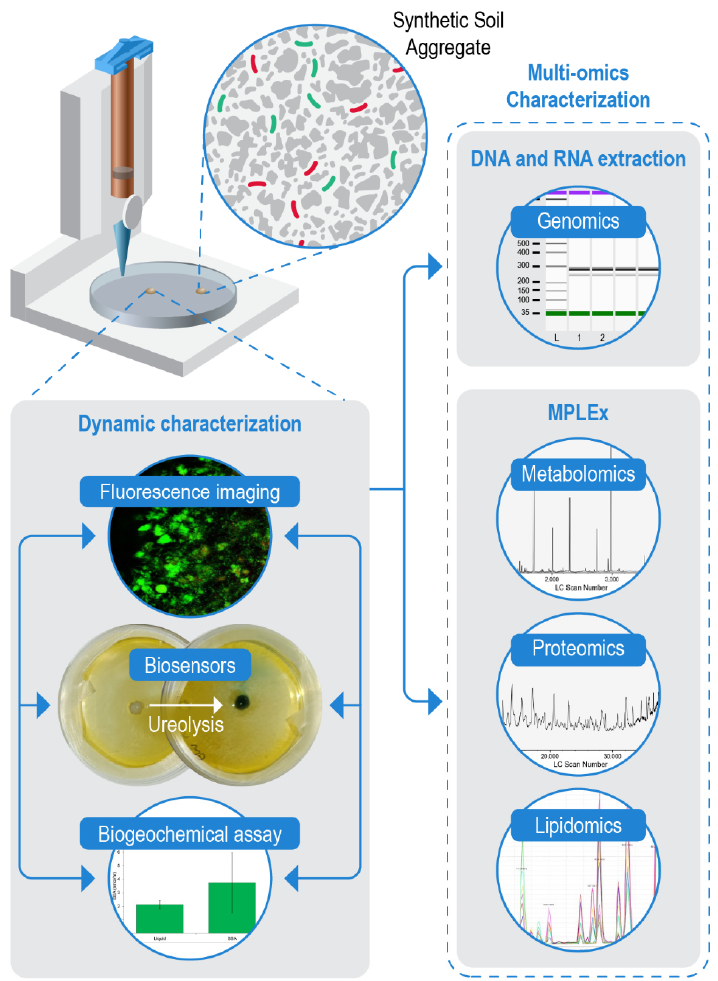
Figure 3. A schematic workflow for integrating SSAs with multi-modal analysis. All aspects of